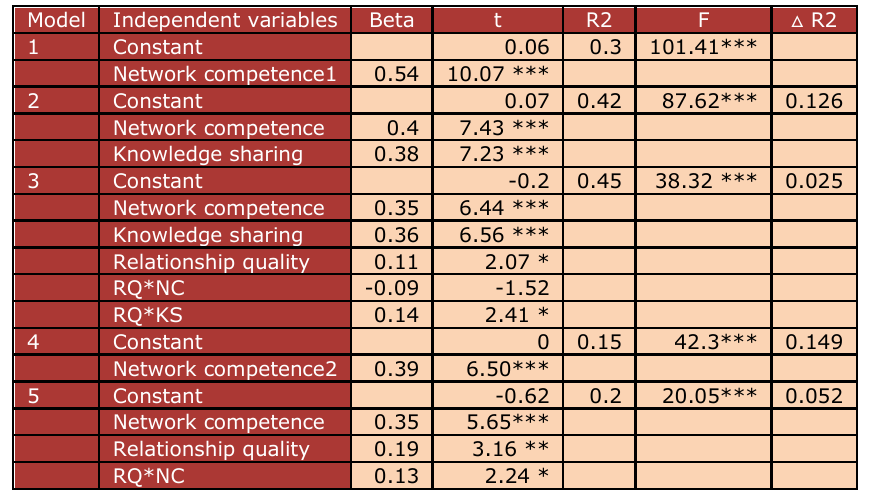
Table 3. Regression Results. (In Model 1, 2, 3 knowledge sharing as mediator, relationship quality as moderator, SIP as dependent variable; in Model 4, 5 relationship quality as moderator,